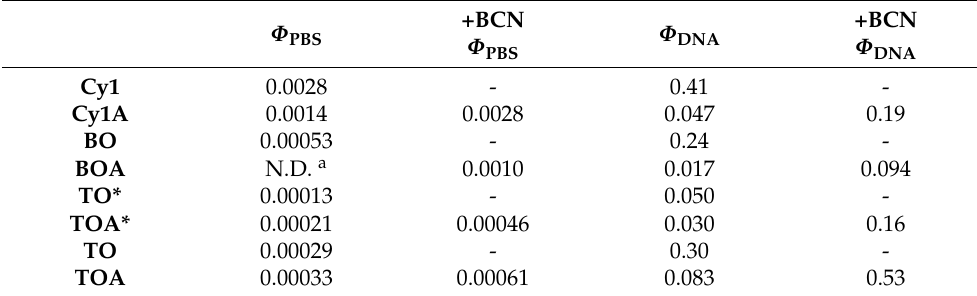
Table 1. Fluorescence quantum yields of Cy1, BO , TO* , and TO frames, their azide modified derivatives, and the BCN conjugates of the azides in the absence and presence of DNA.